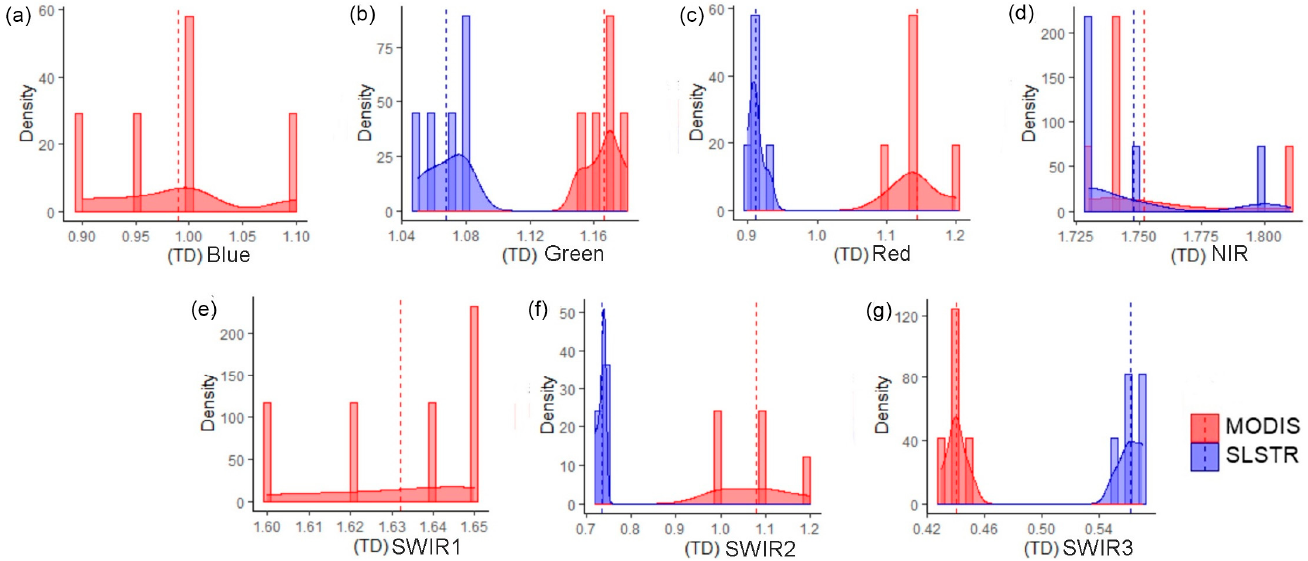
Figure 2. Separability values for the SLSTR (red) and MODIS bands (blue). ( a ) Blue, ( b ) Green, ( c ) Red, ( d ) NIR, ( e ) SWIR1, ( f ) SWIR2), ( g ) SWIR3.